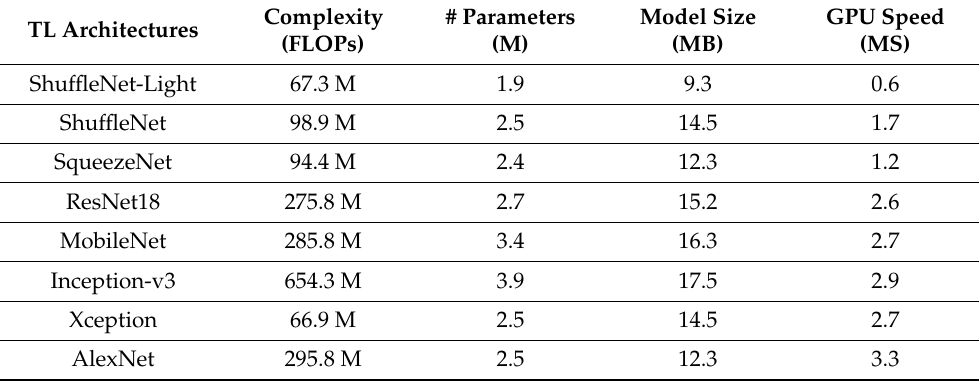
Table 5. Computational performance of the different models.